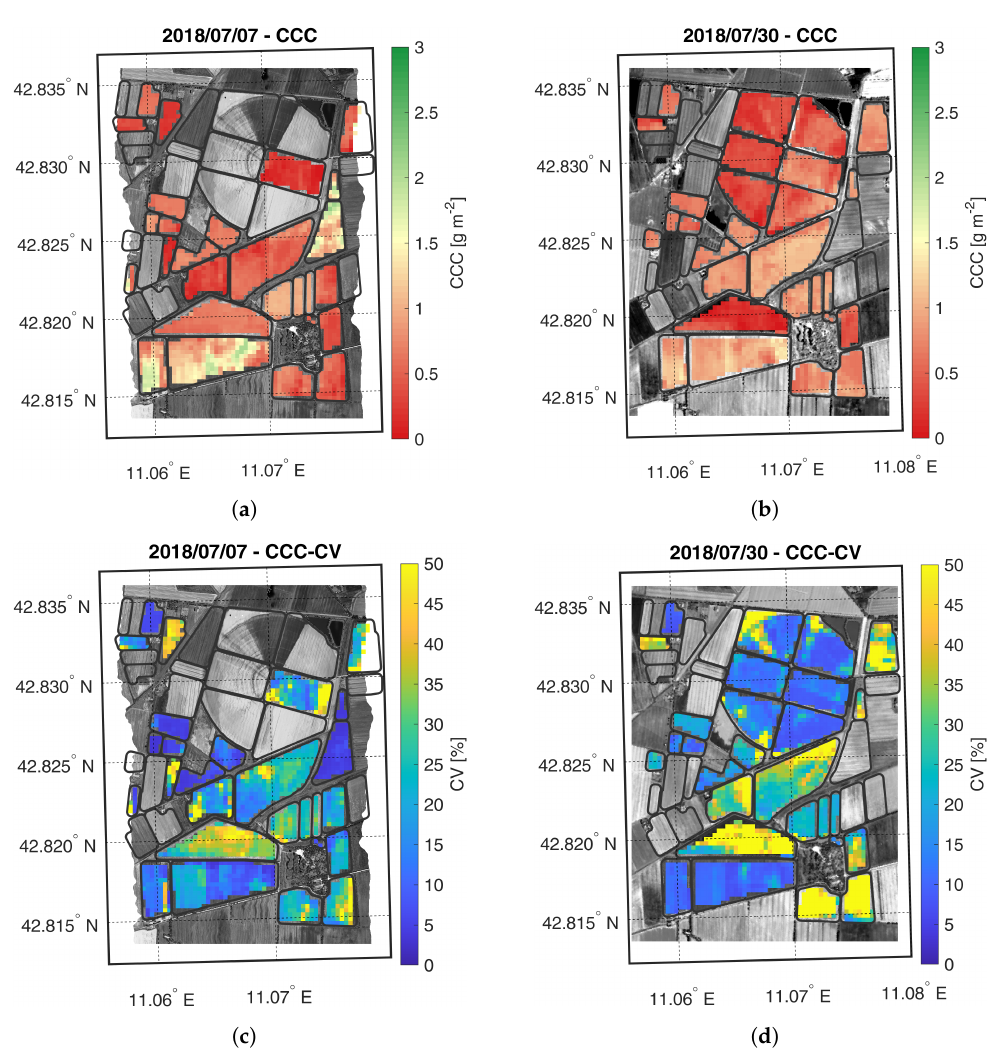
Figure 7. Maps of estimated CCC ( a , b ) and related CV ( c , d ) generated from synthetic CHIME-like images, simulated from the Hyplant-DUAL dataset acquired on 7 and 30 July 2018. The CNC maps, displayed in Figure 8, show a similar trend to their leaf counterpart. On the first acquisition date, the HFC field average value is higher than the LFC average value and these values increase from first to the second acquisition. Compared to CCC, the CNC values were estimated with lower accuracy as shown by CV maps, highlighting possible model flaws, especially for low CNC